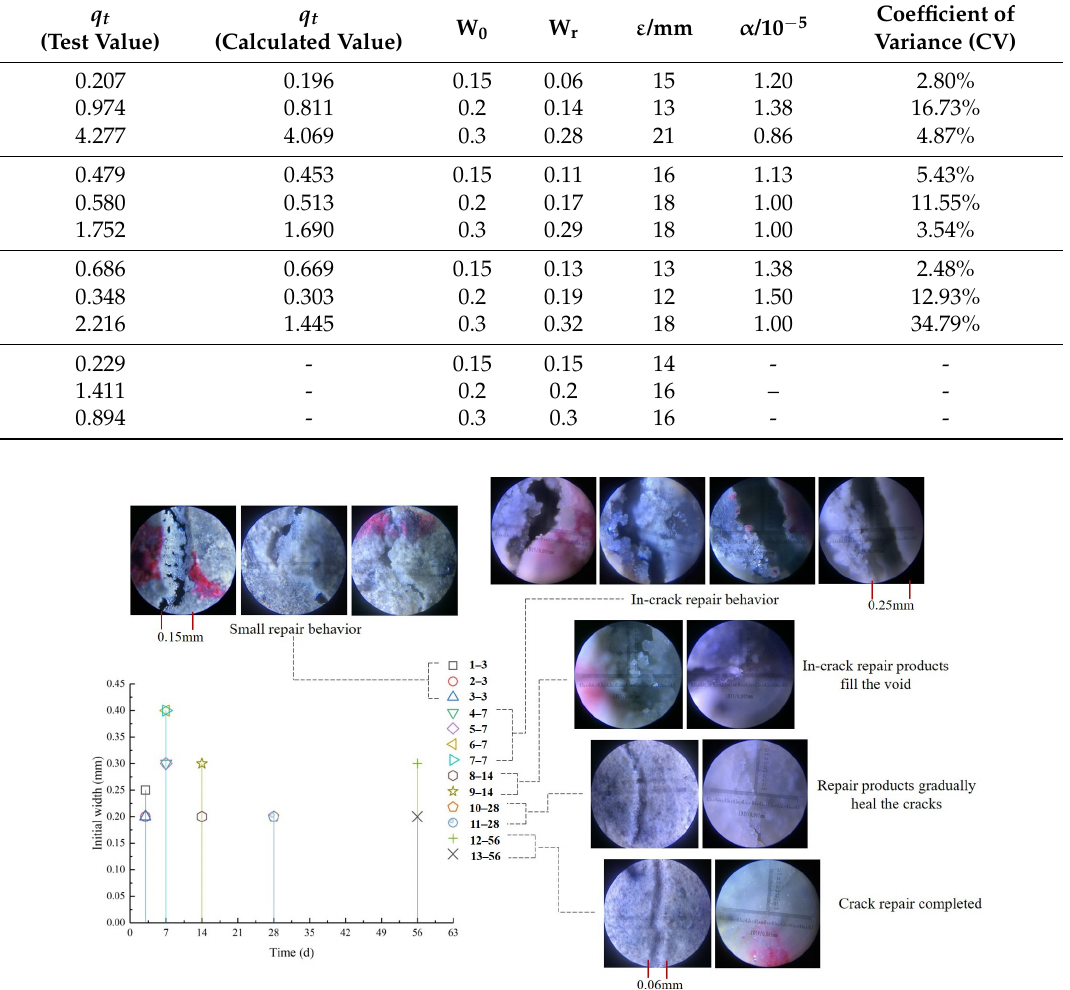
Figure 15. Physical phase analysis of RFA group specimens (Specimen X-Y, X is the marker point number, Y is the measured repair time) .